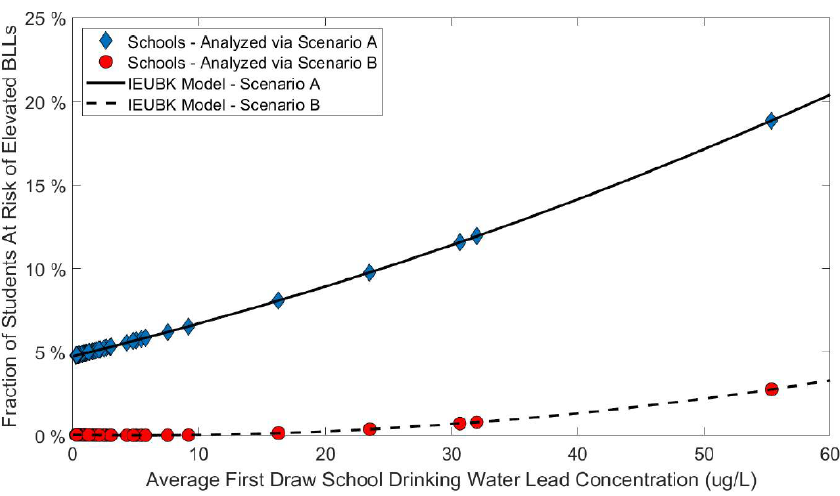
Figure 2. Fraction of at-risk students vs. school water lead concentration.